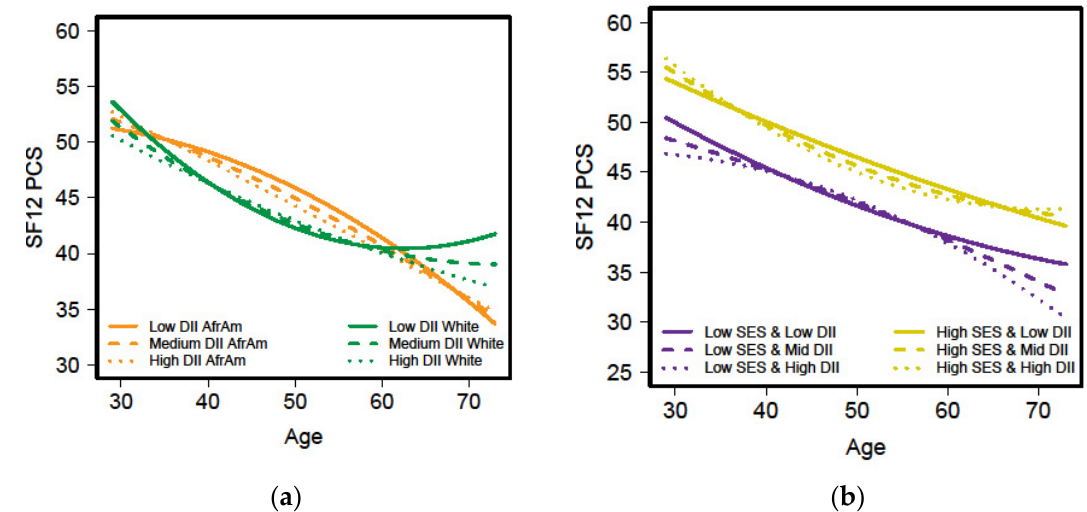
Figure 3. Short Form-12 Physical Component Scores (SF-12 PCS) by age for HANDLS.women across three levels of the dietary inflammatory index (DII) and either race (( a ) African American (AfrAm) and White) or socioeconomic status (( b ) SES). HANDLS-Healthy Aging in Neighborhoods of Diversity across the Life Span.